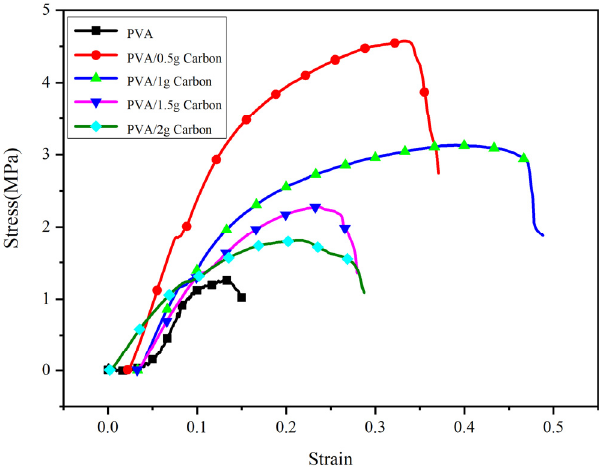
Figure 9. Mechanical property of the nanofiber membrane.